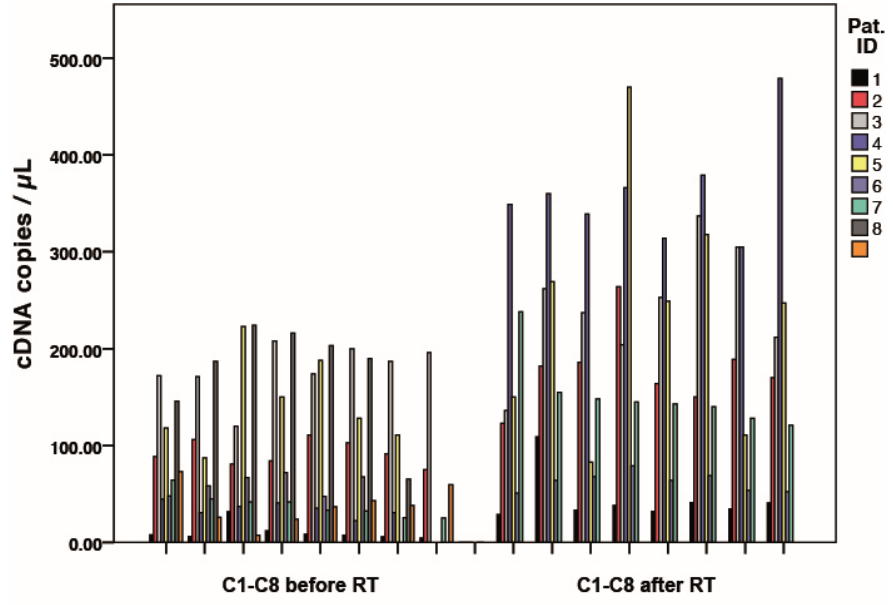
Figure 4. Results of NANOG expression analysis for eight single cells (C1-8) before and after radiotherapy for all patients. Each bar represents the expression of a single tumor cell/patient. Table 5. Quotient (Q) of the CETC number (first row) and quotient of the copy number of genes before and after the end of